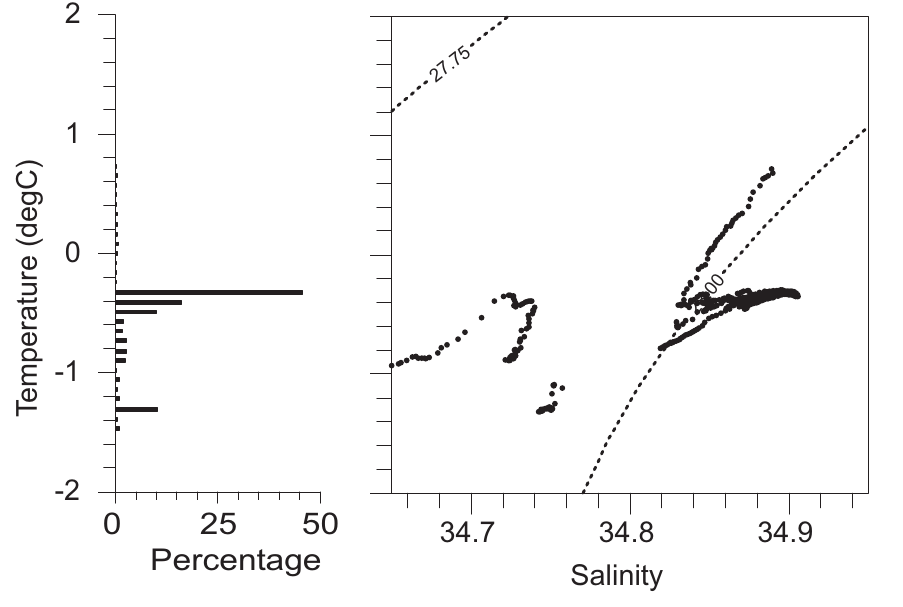
Fig. 3. Histogram of potential tem- perature, and potential temperature vs. salinity of the layer 100m above the bottom in the eastern St. Anna Trough (stations 6–17; stations 11, 13, 14, 16 were left out to provide spatially equal